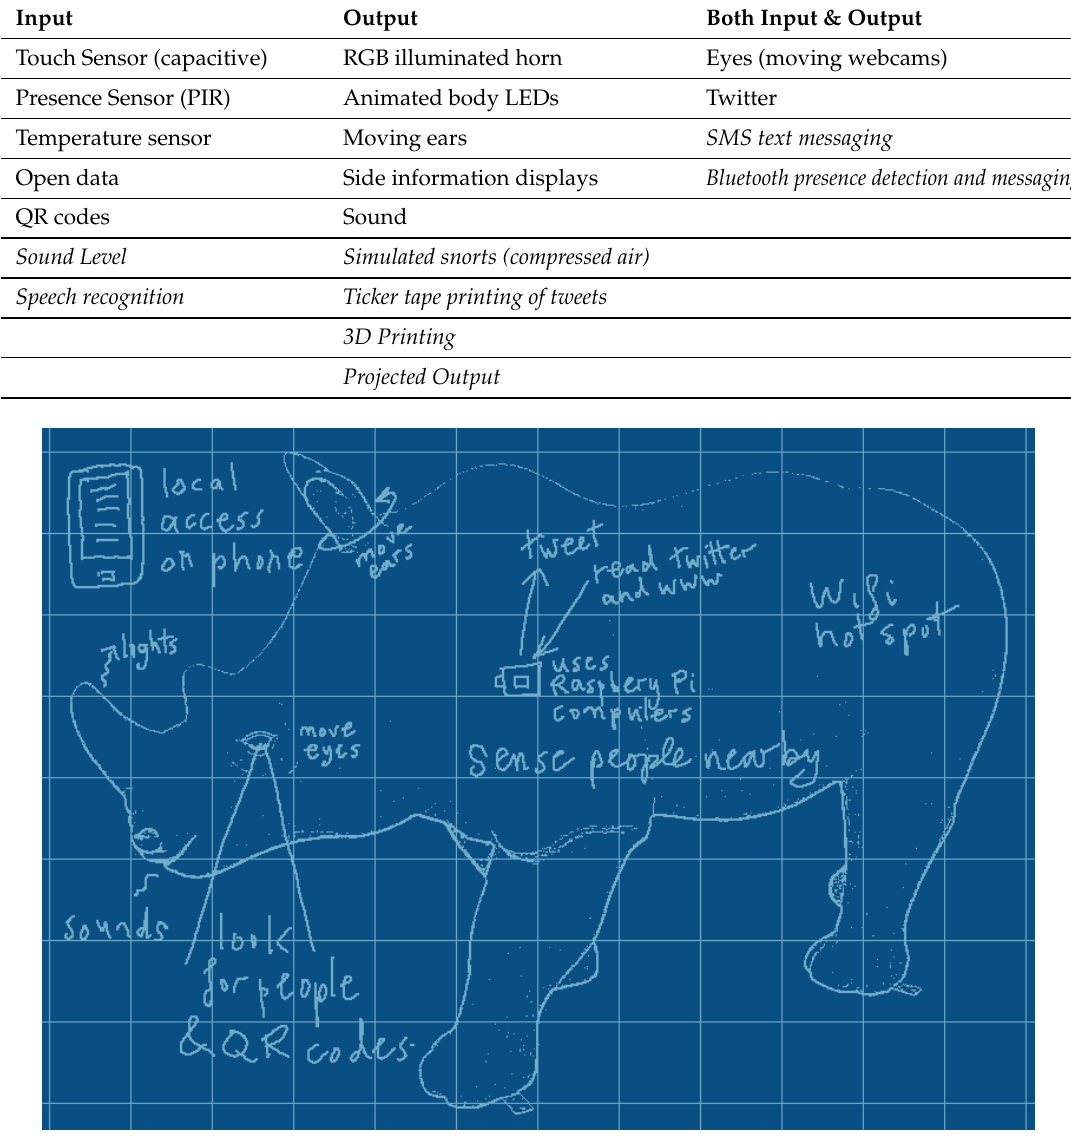
Figure 2. Initial ideas for Erica’s